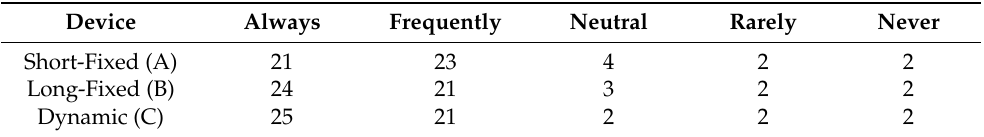
Table 4. The participants’ predisposition towards the use of the devices (each cell indicates the number of participants choosing each level of the answer).